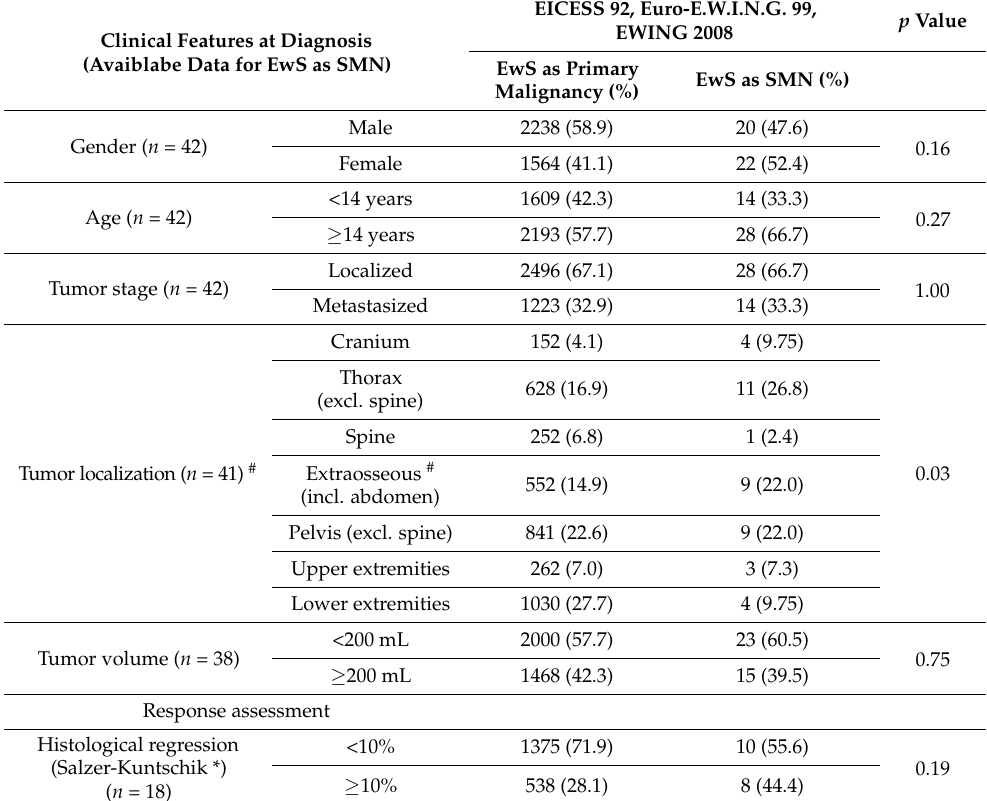
Table 2. Clinical features at diagnosis and response to therapy in comparison between Ewing sarcomas (EwS) as primary malignancy and EwS as secondary malignant neoplasms (SMN) in the EICESS 92, Euro-E.W.I.N.G. 99, and EWING 2008 trials. Fisher’s exact test was used in the analysis of contingency